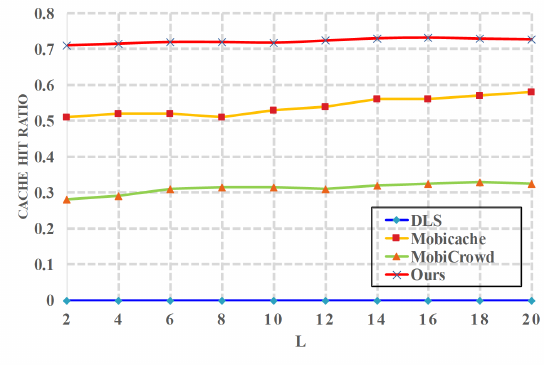
Figure 5. Cache Hit Ratio vs. l .